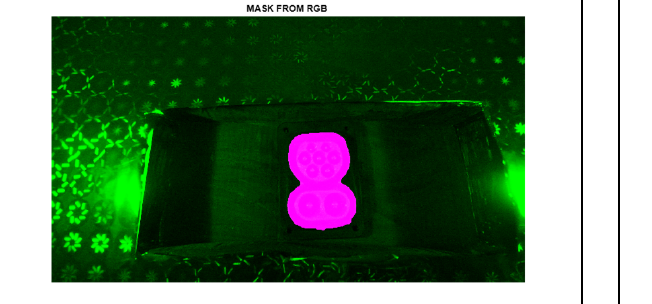
Figure 15. ( a ) Input RGB image, ( b ) result of the intensity transformation, ( c ) obtained binary mask, and ( d ) detected CCS2 connector.